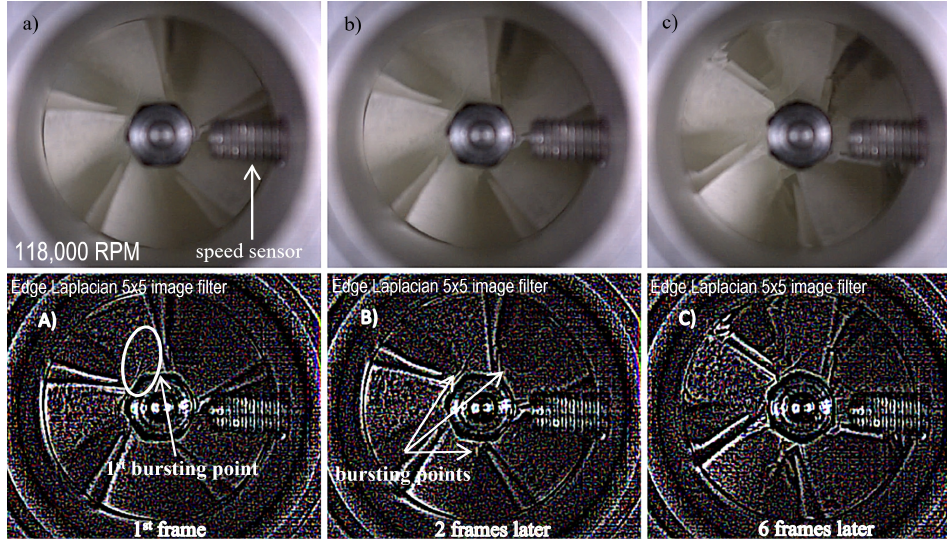
Figure 10. Images obtained at a speed of 118,000 rpm—original images recorded by a camera (top images: ( a ) 1 st frame, ( b ) 2 frames later, ( c ) 6 frames later) and images obtained after using the edge Laplacian filter (bottom images: ( A ) 1 st frame, ( B ) 2 frames later, ( C ) 6 frames